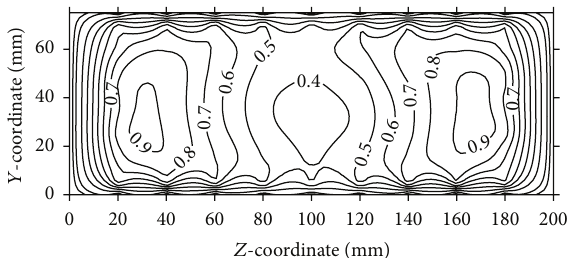
Figure 9: Normalized velocity contours at the outlet for air-intake (best VG